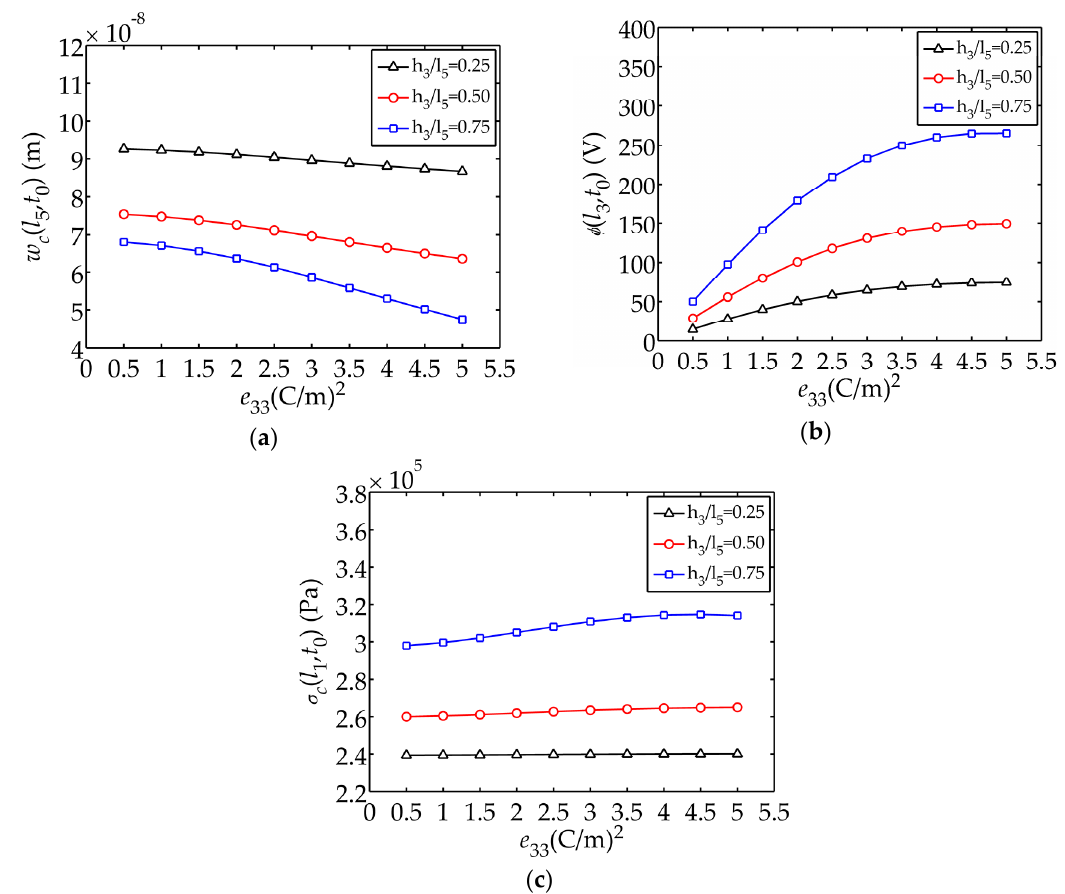
Figure 7. Displacement w c ( l 5 , (cid:1872) (cid:2868) ), electric potential ϕ ( l 3 , (cid:1872) (cid:2868) ) and stress (cid:2026) (cid:3030) ( l (cid:2869) , (cid:1872) (cid:2868) ) changing with e 33 : ( a ) Displacement w c ( l 5 , (cid:1872) (cid:2868) ); ( b ) Electric potential ϕ ( l 3 , (cid:1872) (cid:2868) ); ( c ) Stress (cid:2026) (cid:3030) ( l 1 , (cid:1872) (cid:2868) ). ( a ) Displacement w c ( l , t 0 ) ; ( b ) Electric potential φ ( l 5